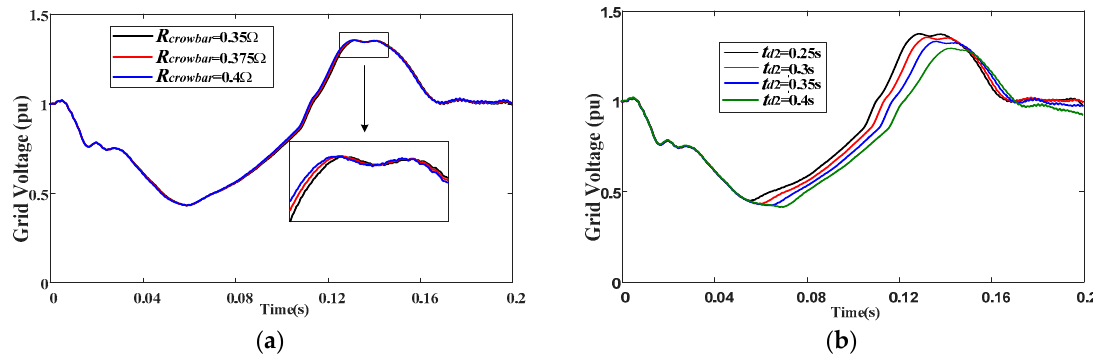
Figure 14. Amplitude of AC bus voltage in the sending ac grid under different crowbar parameters. ( a ) Actual crowbar resistor value ( t d 2 = 0.3s); ( b ) minimum connection time ( R crowbar = 0.35 Ω ).